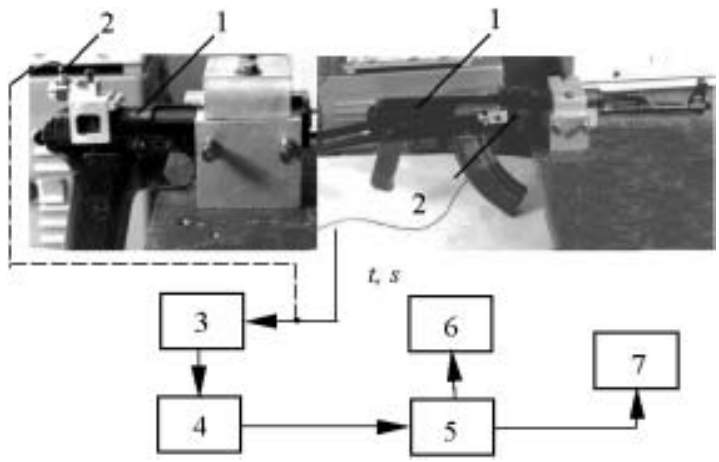
Fig. 1. Research scheme of the lock dynamics during single shots and serials: 1 – gun (pistol or storm carabine), 2 – piezoelectric sensor KD 17, 3 – vibration meter RFT, 4 – converter – code – analog, 5 – PC, 6 – monitor, 7 – printer.